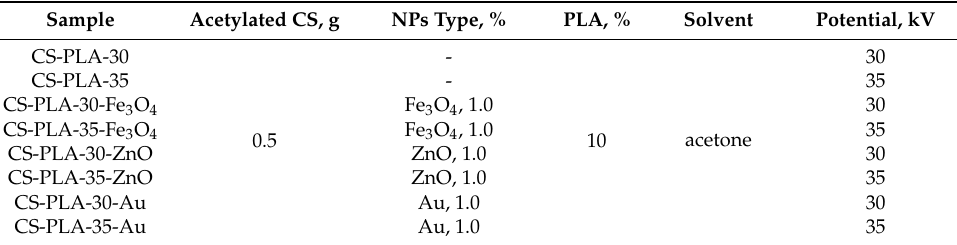
Table 1. Sca ff olds